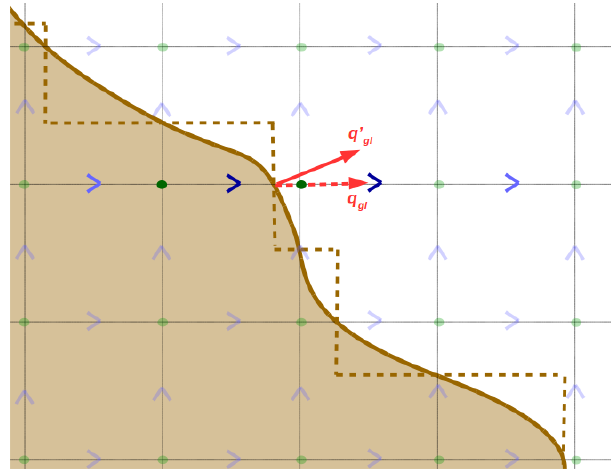
Figure 2. Horizontal staggered grids used in the model. The blue arrows stand for the staggered velocity grid, while the green circles represent the standard centred grid (for, e.g. ice thickness, temper- ature, effective pressure). The plain brown line is an illustration of the grounding line position with an example of the flux ( q (cid:48) location where the grounding line crosses the x axis in the centred grid. In the model, the norm of the flux at this location is reported on the u velocity only ( q gl ), i.e. assuming a grounding line perpendic- ular to the x axis (dashed brown line). The dark blue arrows are the velocity nodes on which q gl is interpolated, using the velocity val- ues of the two bounding light blue arrows. The dark green dots are used to infer the sub-grid position of the grounding, interpolating the floatation criterion ( ρH + ρ w (B − sealevel )